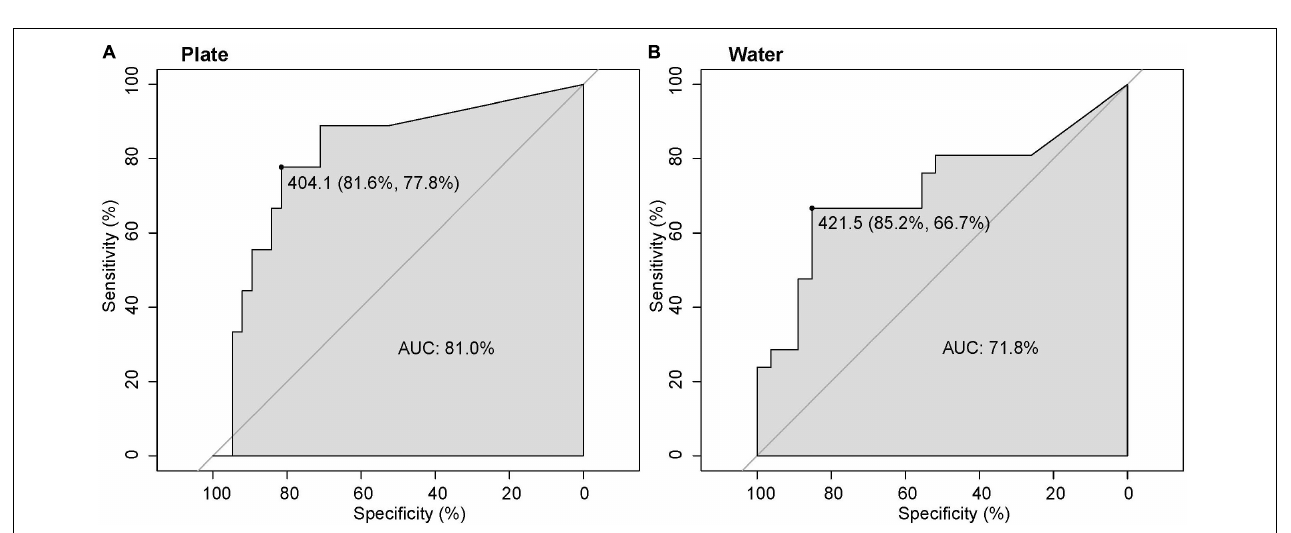
FIGURE 1 | Boxplots displaying log(x+1) transformed DNA or RNA copy numbers per sample and determined by droplet digital PCR for plate and water samples over the study period. Colors align with sampling dates.